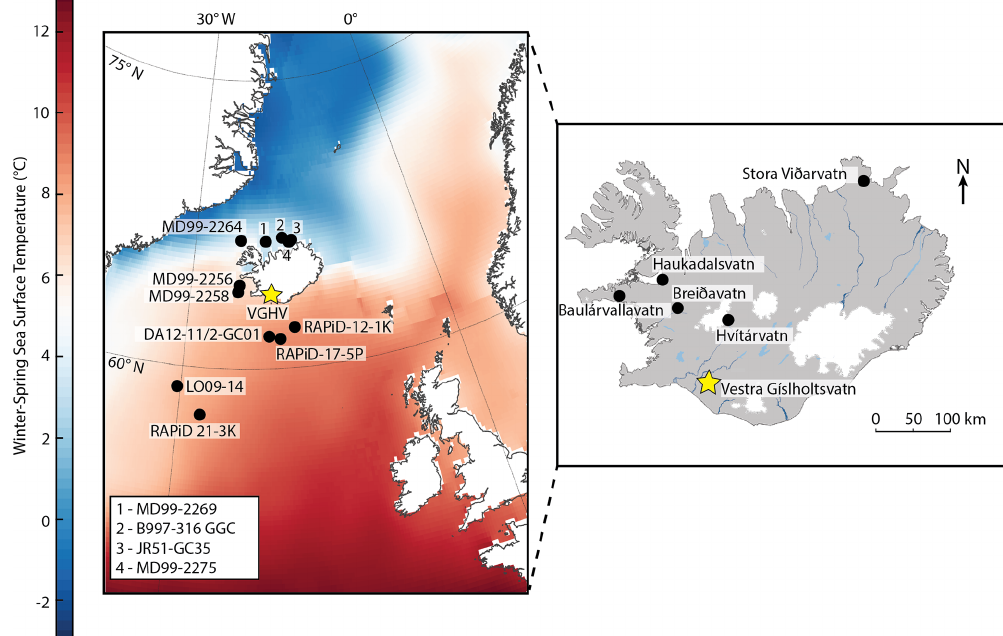
Figure 1. Map of mean winter–spring (DJFMAM) sea surface temperatures from 1955–2017 in the high North Atlantic region. The marine sediment cores MD99-2269 (Moros et al., 2006; Justwan et al., 2008; Cabedo-Sanz et al., 2016), B997-316 GGC (Harning et al., 2019), JR51-GC35 (Cabedo-Sanz et al., 2016), MD99-2275 (Jiang et al., 2005, 2015; Massé et al., 2008; Sicre et al., 2008; Ran et al., 2011), MD99-2264 (Ólafsdóttir et al., 2010), MD99-2256 (Ólafsdóttir et al., 2010), MD99-2258 (Axford et al., 2011), DA12-11/2-GC01 (Orme et al., 2018; Van Nieuwenhove et al., 2018), RAPiD-12-1K (Thornalley et al., 2009), RAPiD-17-5P (Moffa-Sánchez et al., 2014), LO09-14 (Berner et al., 2008), and RAPiD 21-3K (Sicre et al., 2011; Miettinen et al., 2012) that are discussed in the text are indicated. The locations of lake sediment records from Stora Viðarvatn (Axford et al., 2009), Haukadalsvatn (Geirsdóttir et al., 2009), Baulárvallavatn (Holmes et al., 2016), Breiðavatn (Gathorne-Hardy et al., 2009), and Hvítárvatn (Larsen et al., 2011) are indicated. The study site, Vestra Gíslholtsvatn (VGHV), is marked by a yellow star. The maps were made using data from Natural Earth, the National Land Survey of Iceland, and the National Oceanic and Atmospheric Administration (NOAA) World Ocean Database (Boyer et al.,